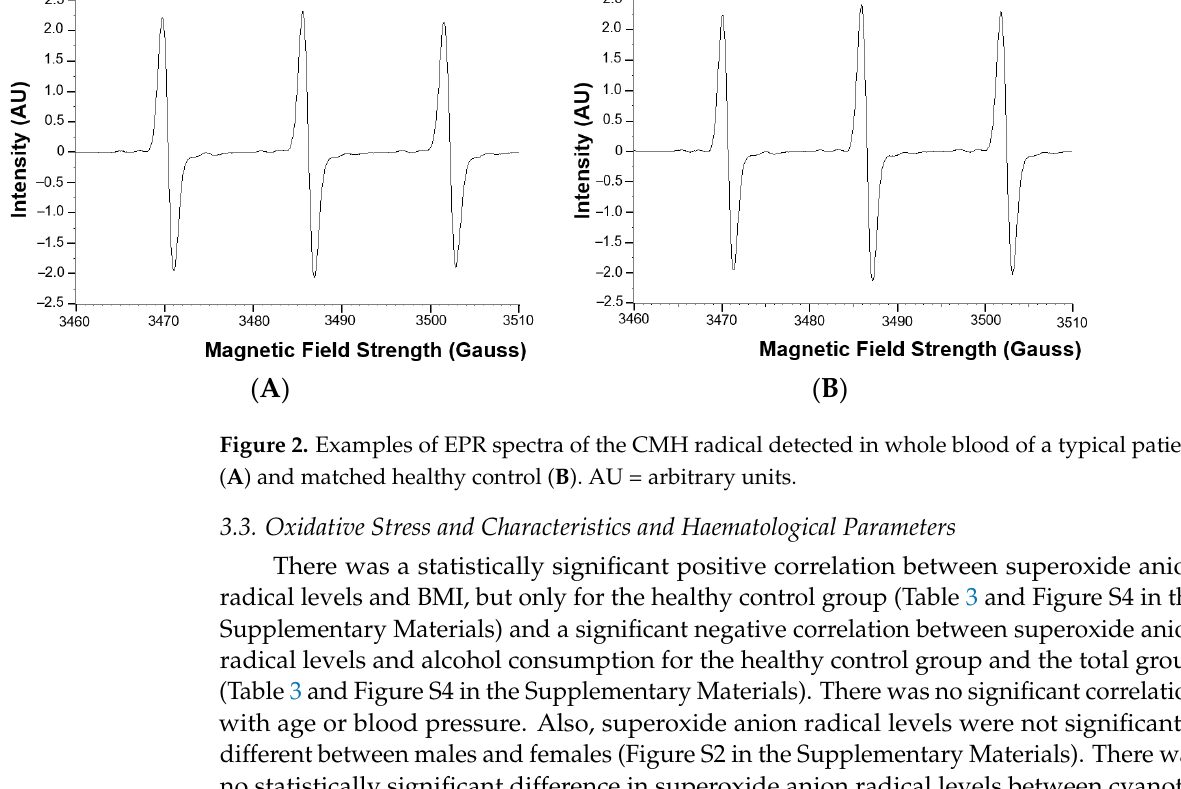
Table 3. Correlation coefficients between superoxide anion radical levels and characteristics, hemato- logical parameters, exercise capacity and peripheral microvascular endothelial function.